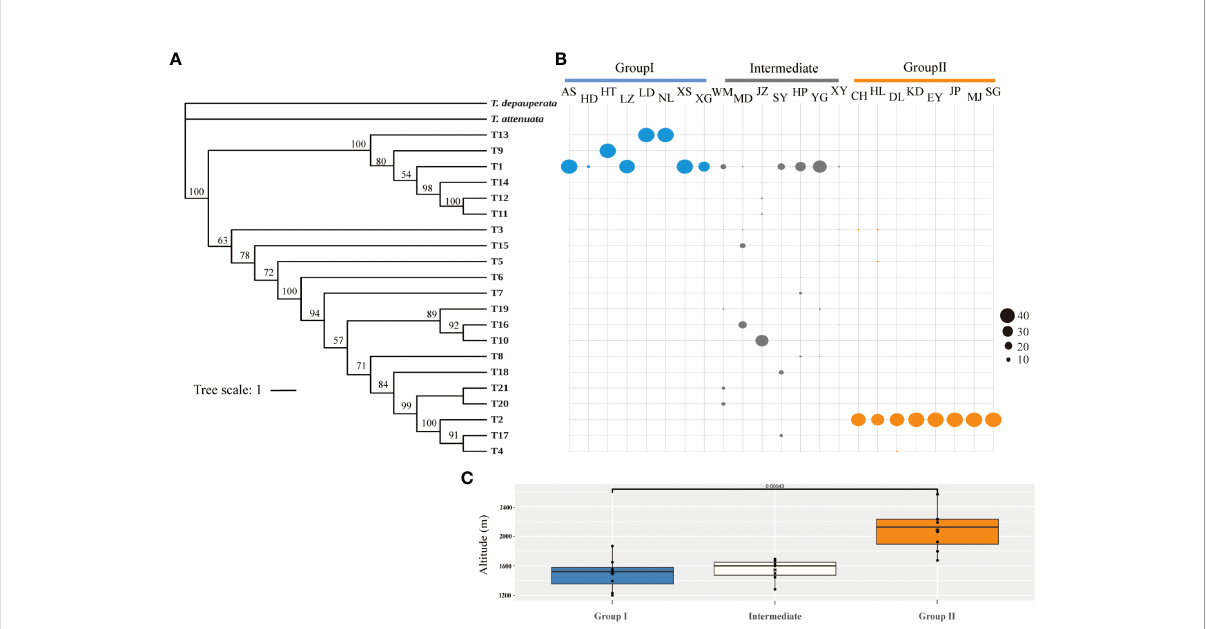
FIGURE 3 The abundance of ITS haplotypes and altitudinal variation between different population groups. (A) tree on the left represents the phylogenetic relationships among haplotypes. (B) ITS haplotypes abundance across 23 populations. Horizontal lines correspond to the haplotypes shown on the phylogenetic tree. Haplotype abundance in each population (vertical lines) is indicated by diameter of the circles, following the scale shown at the right. (C) Boxplot of altitude for the three groups of H. lichiangensis . Boxplot of altitude for the three groups of H. lichiangensis . Box-and- whisker plots indicate the median (horizontal line), 25th and 75th percentiles (bottom and top of the box), and limits of the 95% con fi dence intervals (lower and upper whiskers). Dots beyond the 95% con fi dence intervals are outliers. *P <